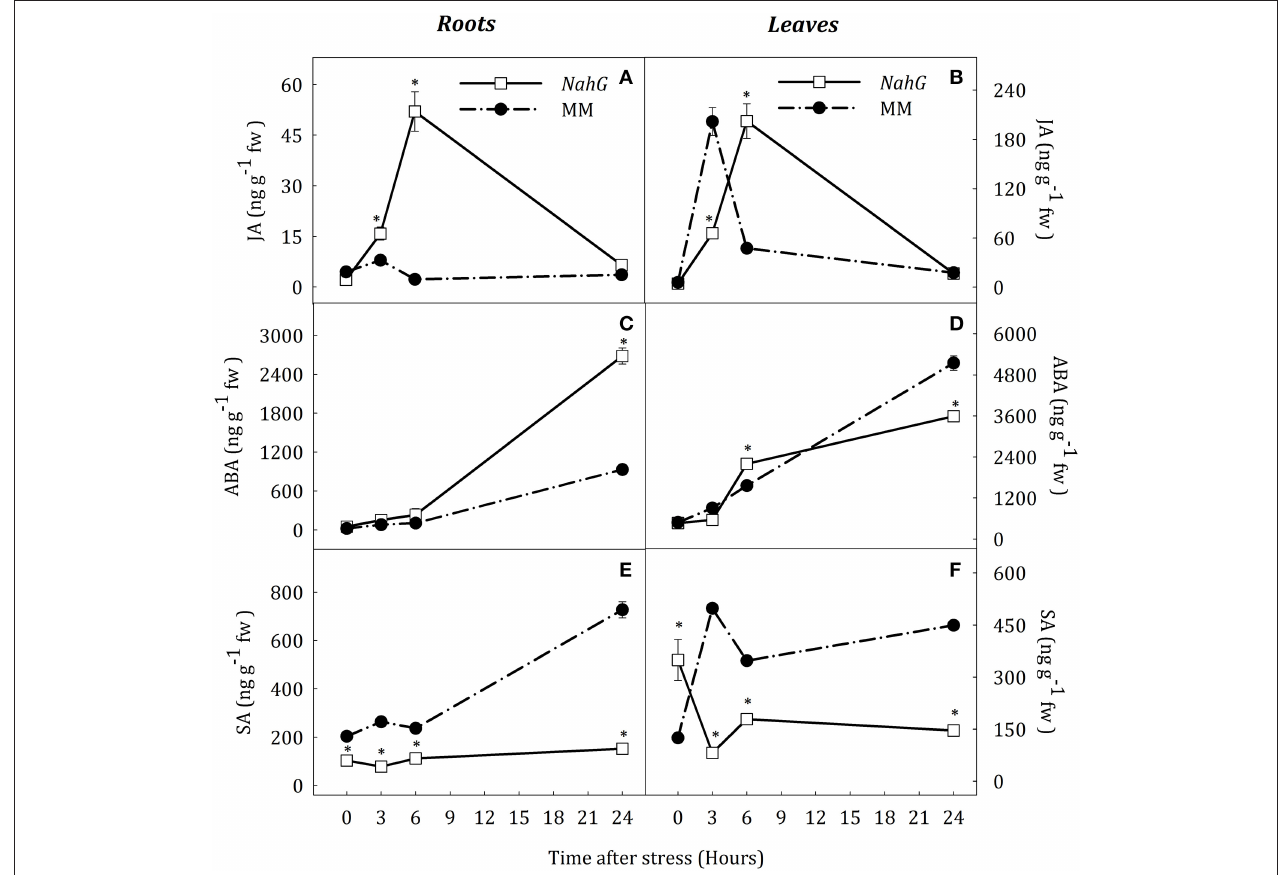
FIGURE 10 | JA (A,B), ABA (C,D) and SA (E,F) endogenous concentrations in leaves and roots of Solanum lycopersicum [WT (MM, black circles) and NahG line (white square)] under control ( t = 0 ) and water-stress conditions. Data are mean values ± standard deviation of three independent determinations. Asterisks denote statistical difference with respect to WT at p ≤ 0.05